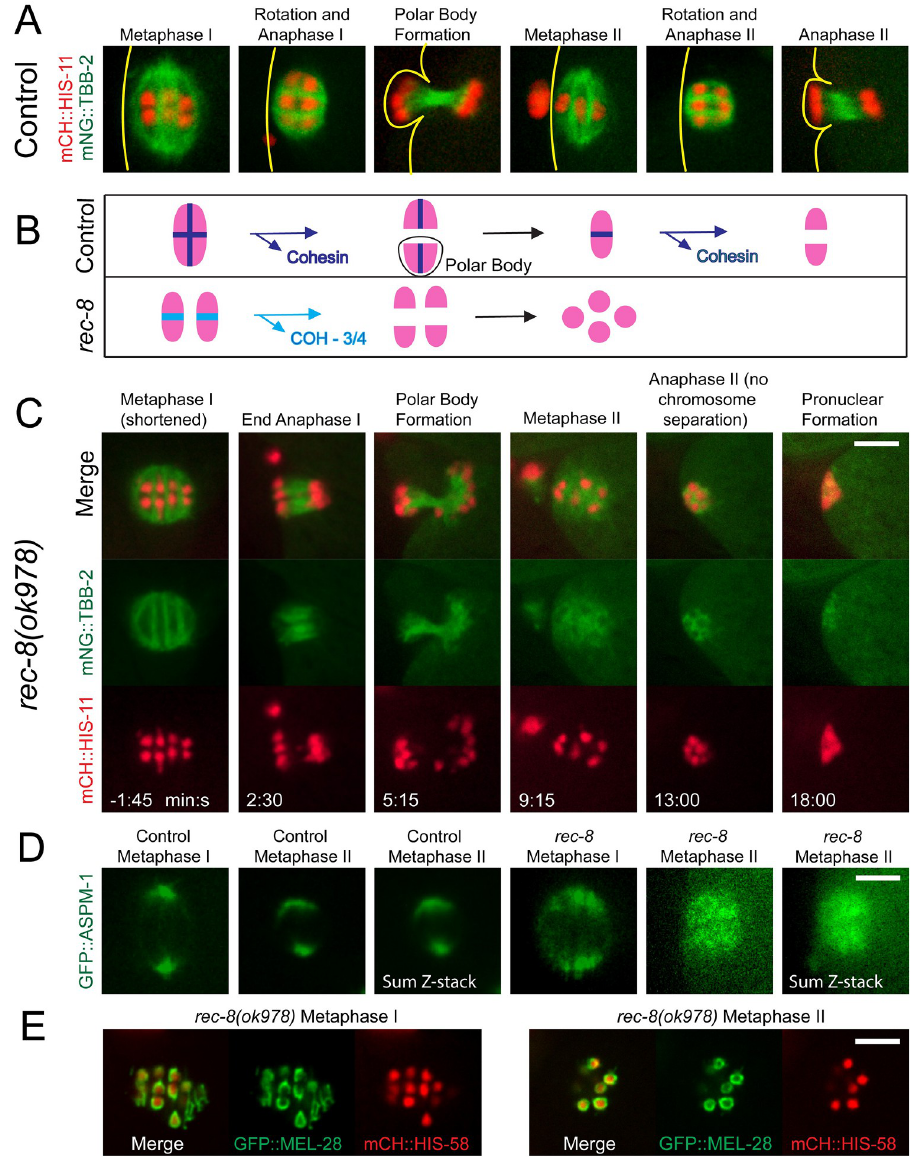
Fig 1. Metaphase II spindles are apolar in rec-8(ok978) . (A) In 8/8 control embryos, bipolar MI spindles shorten and rotate, chromosomes segregate, and a polar body forms. The cycle repeats with a bipolar MII spindle. Lines indicate the position of the cortex. (B) In metaphase I, both sister chromatids and homologs are bound by cohesin containing both REC-8 and COH-3/4 (dark blue); homologs are released and separate in Anaphase I; sister chromatids are released and separate in Anaphase II. In rec-8(ok978) , COH-3/4 cohesin (light blue) is present in an expanded region between sister chromatids in MI and no cohesin is present in MII. (C) Time-lapse imaging of rec-8(ok978) expressing mNG::TBB-2 and mCH::HIS-11. The metaphase II spindle appears disorganized and no anaphase chromosome separation occurs in 8/8 embryos. 0 minutes is the end of MI spindle rotation. (D) Control and rec-8(ok978) embryos expressing GFP::ASPM-1. Single-focal plane imaging was ended at metaphase II and z-stacks were acquired. 7/7 control MI spindles, 7/7 rec-8 MI spindles, and 7/7 control MII spindles were bipolar. 8/8 rec-8 MII spindles were apolar. (E) Imaging of rec-8 embryos expressing GFP::MEL-28 revealed kinetochore cups in 4/4 MI spindles and chromatids enclosed by GFP::MEL-28 in 7/7 MII spindles. All bars = 4 μ m.